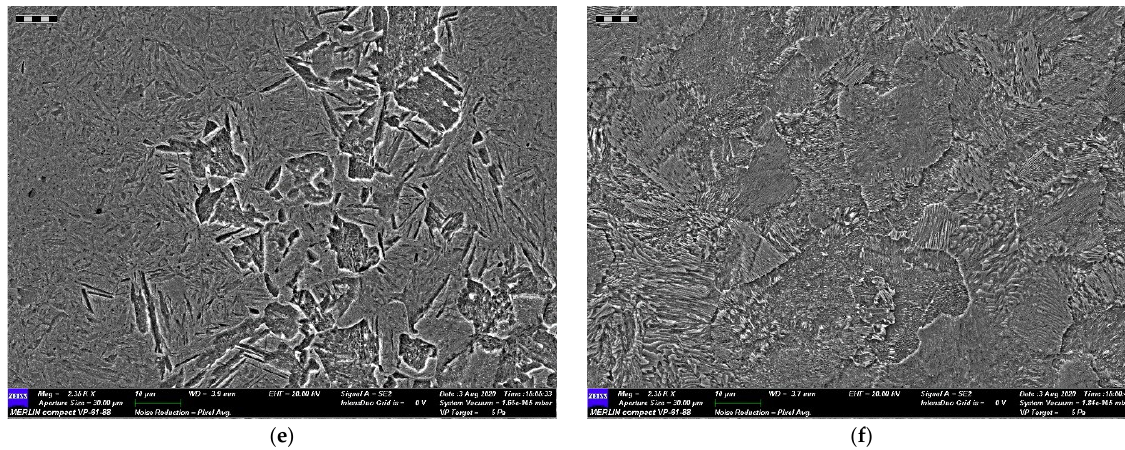
Figure 8. 55Cr3 SEM images of the microstructure cooled at ( a ) 100 °C/s, ( b ) 30 °C/s, ( c ).20 °C/s, ( d ) 10 °C/s, ( e ) 1 °C/s, and ( f ) 0.1 °C/s.